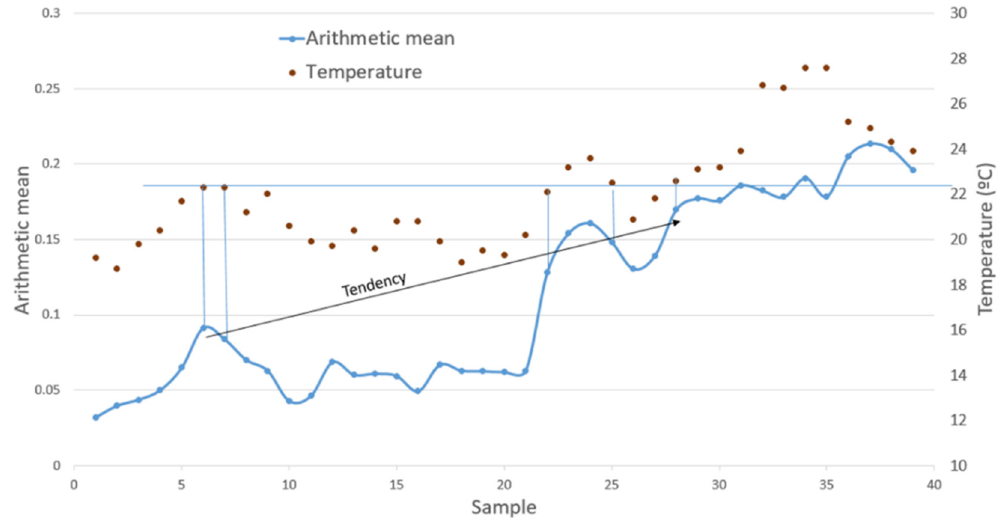
Figure 11. The arithmetic mean vs. temperature in the aluminum plate during the test campaign. Graphical analysis of the variation. Graphical analysis of the